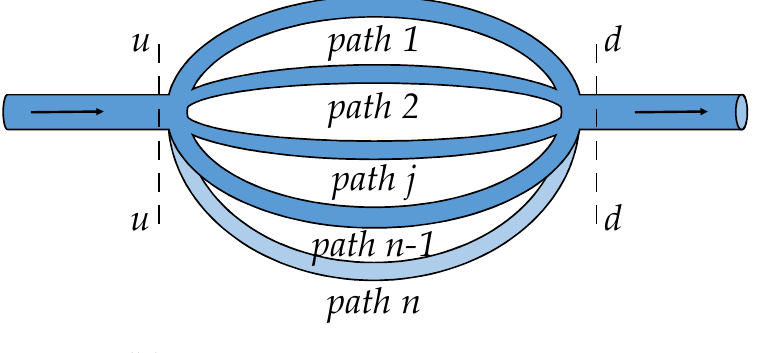
Figure 5. Parallel Figure 5. Parallel system.